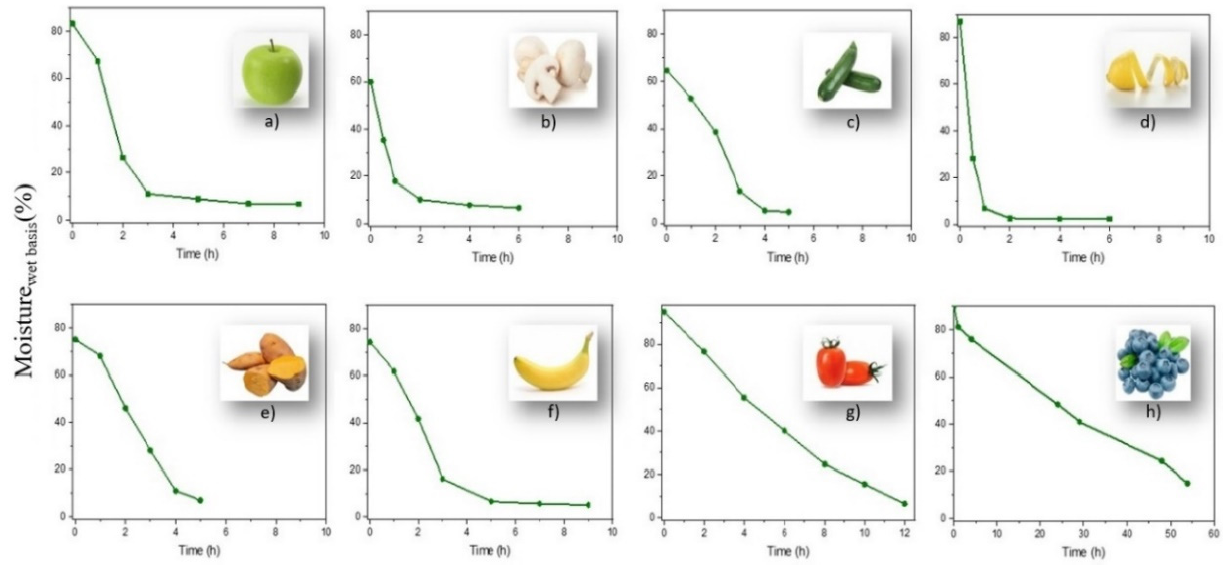
Figure 9. Drying curves (wet basis) of ( a ) apples, ( b ) mushrooms, ( c ) zucchinis, ( d ) lemon peel, ( e ) sweet potatoes, ( f ) bananas, ( g ) tomatoes, ( h ) blueberries.